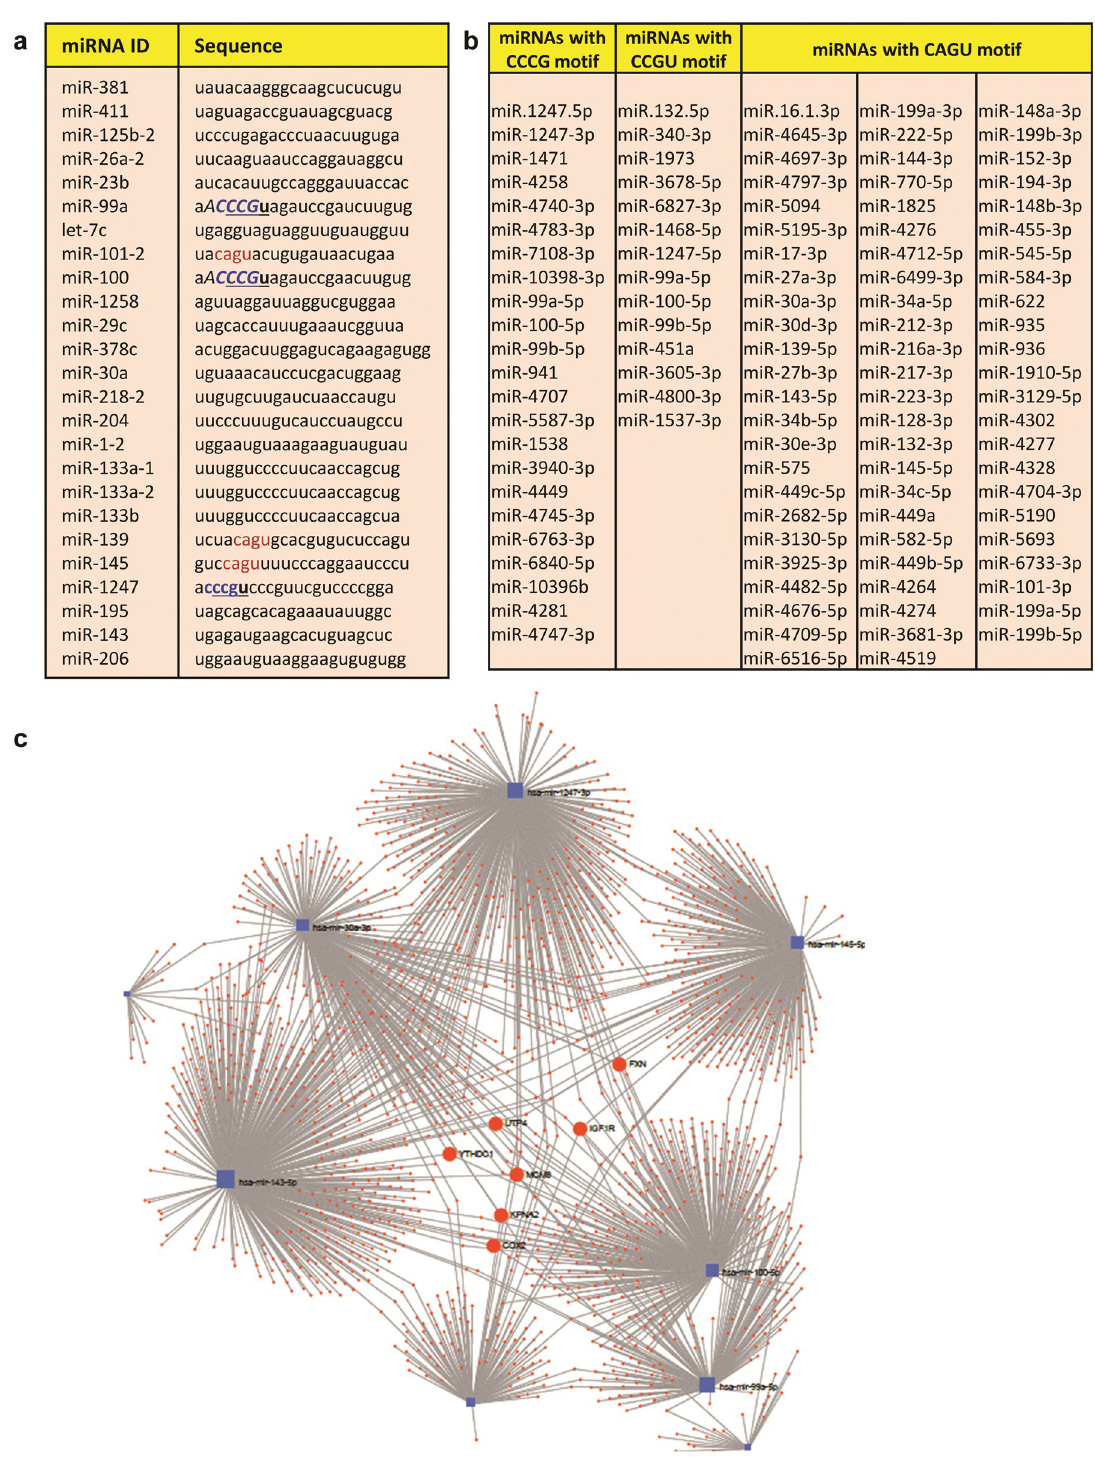
Fig 2. A fraction of tumor-suppressive miRNAs are characterized by specific short nucleotide motifs. ( a ). The frequency of certain four- and five-nucleotide motifs in the seed regions of normomiRs: the CCCG motif (blue) was found in miR-100, miR-99a, and miR- 1247, the CCGU motif (underlined sequence) was present in in the same three normomiRs, the CAGU motif (red) was found in miR- 101, miR-139, and miR-145, the CCCGU motif ( bold ) was present in miR-99a, -100, and -1247, and the ACCCG motif ( italic ) was present in miR-99a and miR-100. ( b ). The list of all miRNAs across human miRNome containing the CCCG, CCGU, and/or CAGU